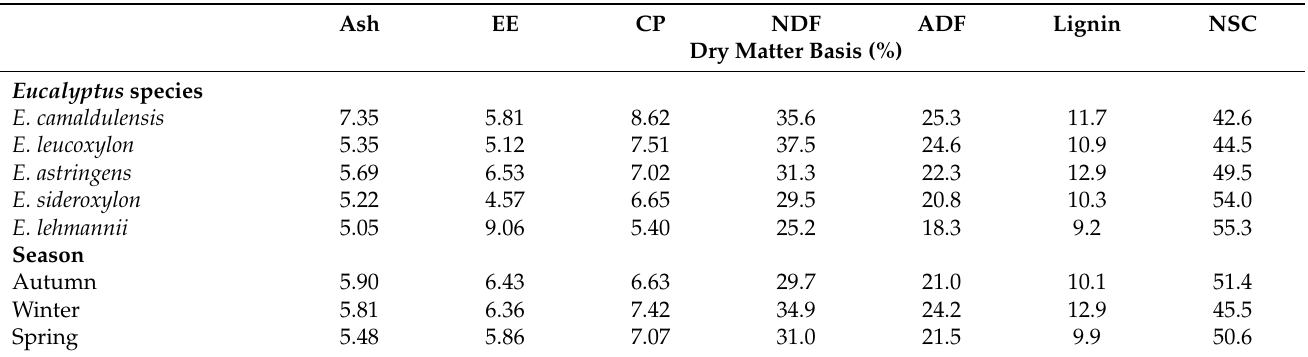
Table 1. Chemical composition of foliage from eucalyptus species harvested in different seasons Horst et al.